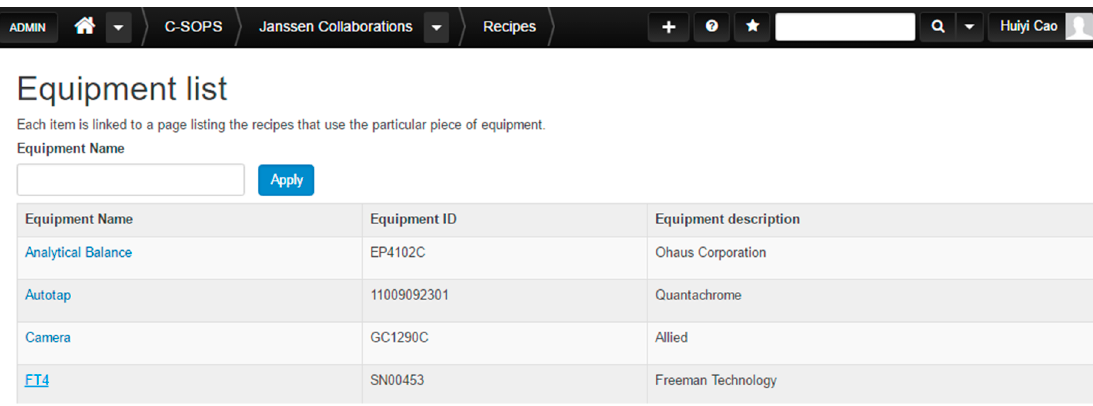
Figure 15. Equipment list in ELN system.